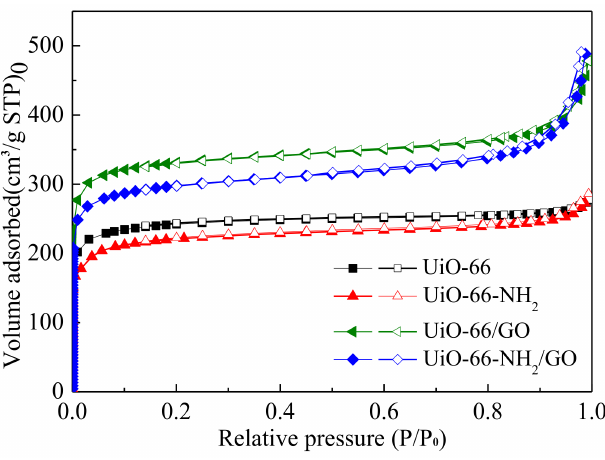
Figure 3. N 2 adsorption-desorption isotherms of the different samples at 77 K.